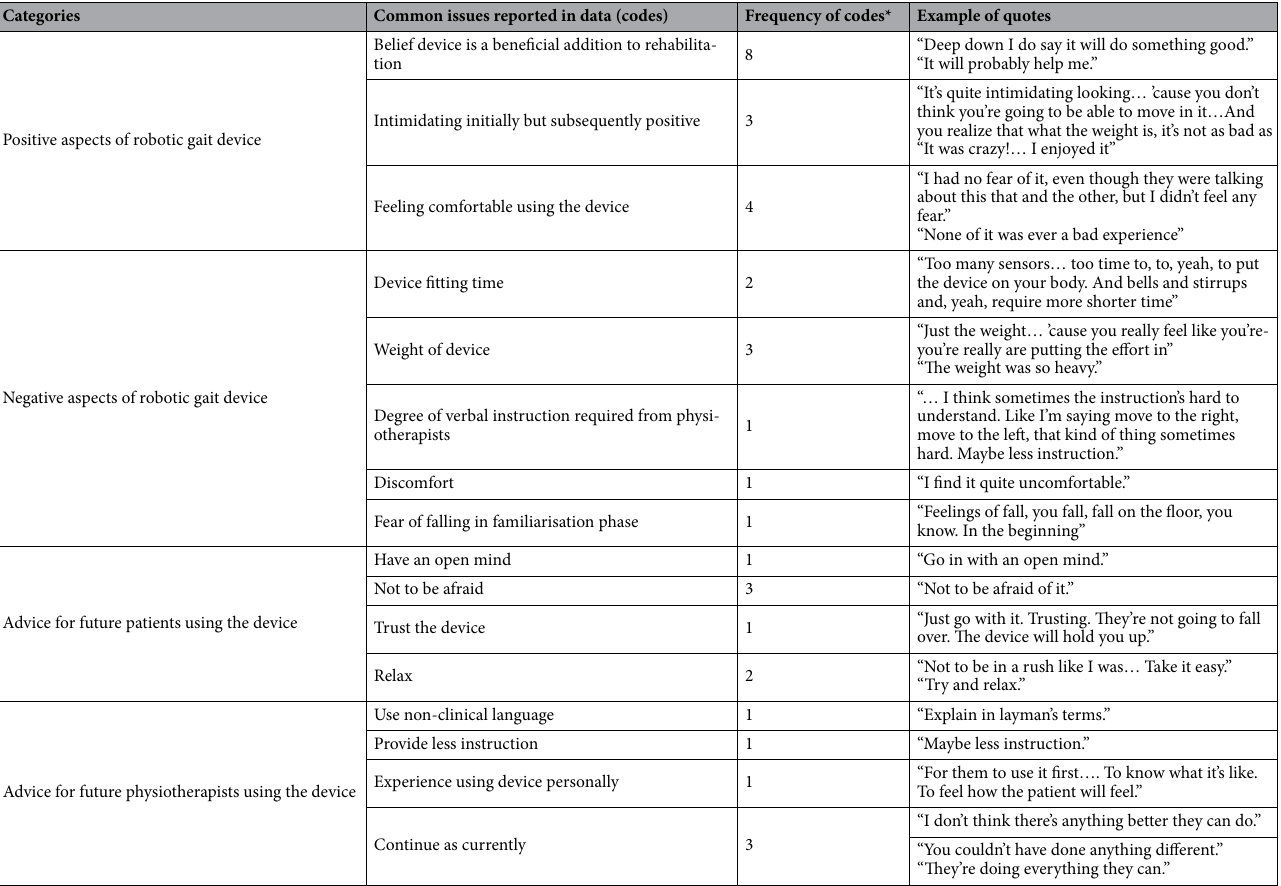
Table 3. Interview data. *Frequency of codes indicates the number of times the code was mentioned in the transcripts.